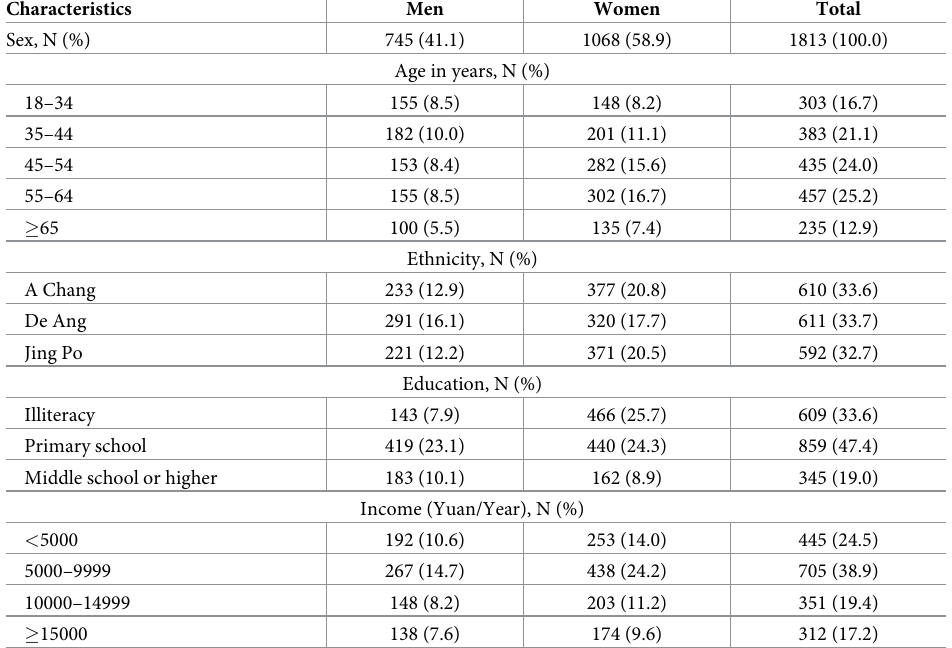
Table 1. Sociodemographic characteristics of the participants.